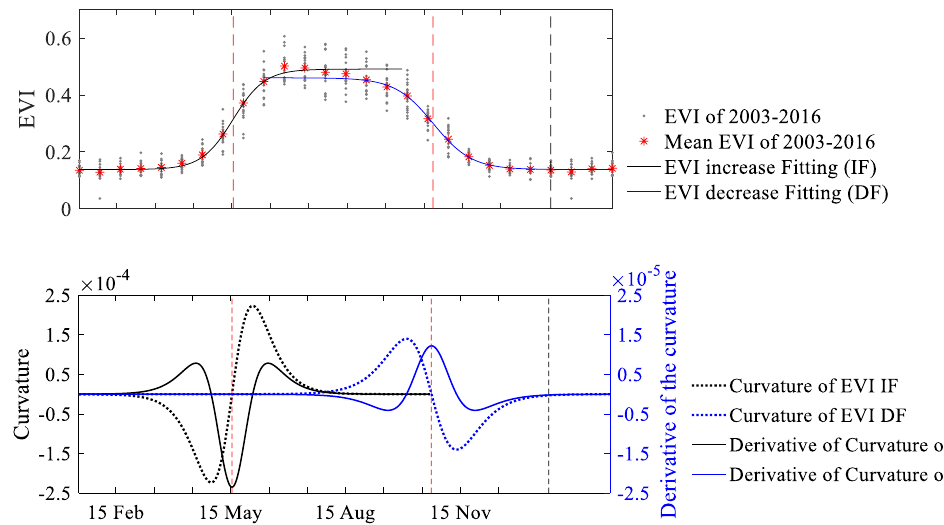
Figure 2. Example of how the growing period is identified from aggregated enhanced vegetation index (EVI) values from 2003 to 2016 data for a single grid cell (Lat = 33.5 ◦ N, Lon = 104.5 ◦ E). The symbol legends explain the original observations and the mean values. The original EVI values (gray points) for all years, mean seasonal EVI (red points), and EVI fitting results (black for spring increase and blue for fall decrease) are shown in the top panel. Curvature and derivative of the curvature of EVI fitting (black for increase and blue for decrease) are shown in bottom panel. The period between the two red dash lines was identified as the growing period for this grid cell.